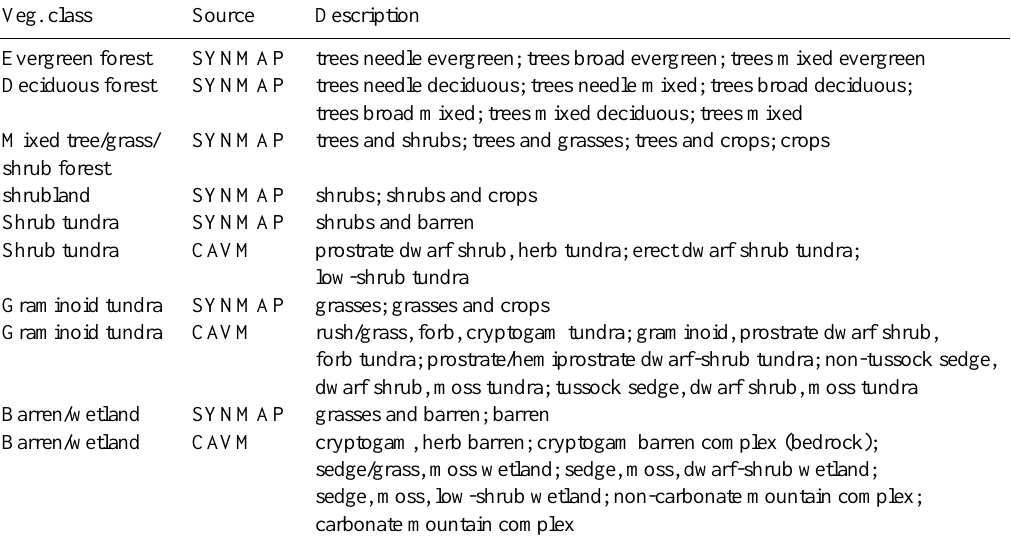
Table 1. PolarVPRM vegetation classes, created by combining and aggregating CAVM and SYNMAP vegetation classes. SYNMAP tree classes are described according to leaf type (broad, needle or mixed) followed by leaf longevity (evergreen, deciduous, or mixed), as in Jung et al. (2006). Veg. class